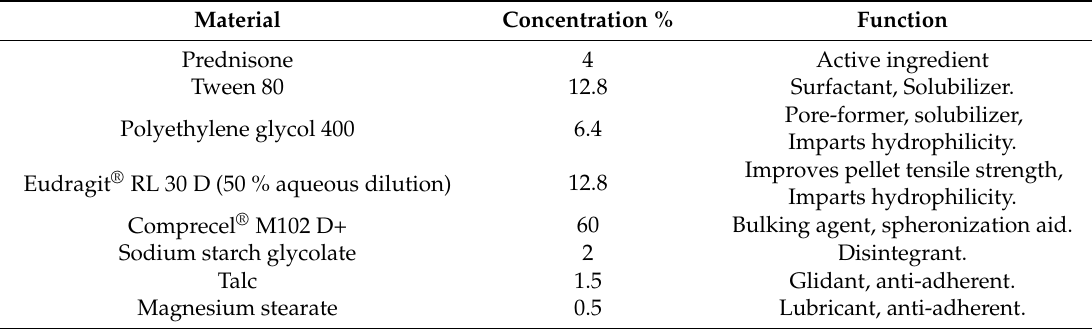
Table 5. Optimum formulation composition for prednisone pellets.